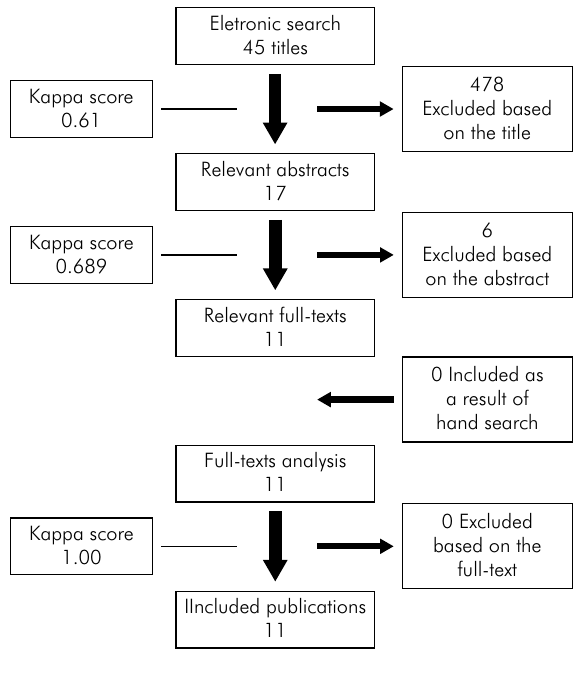
Figure 1. Simplified search strategy